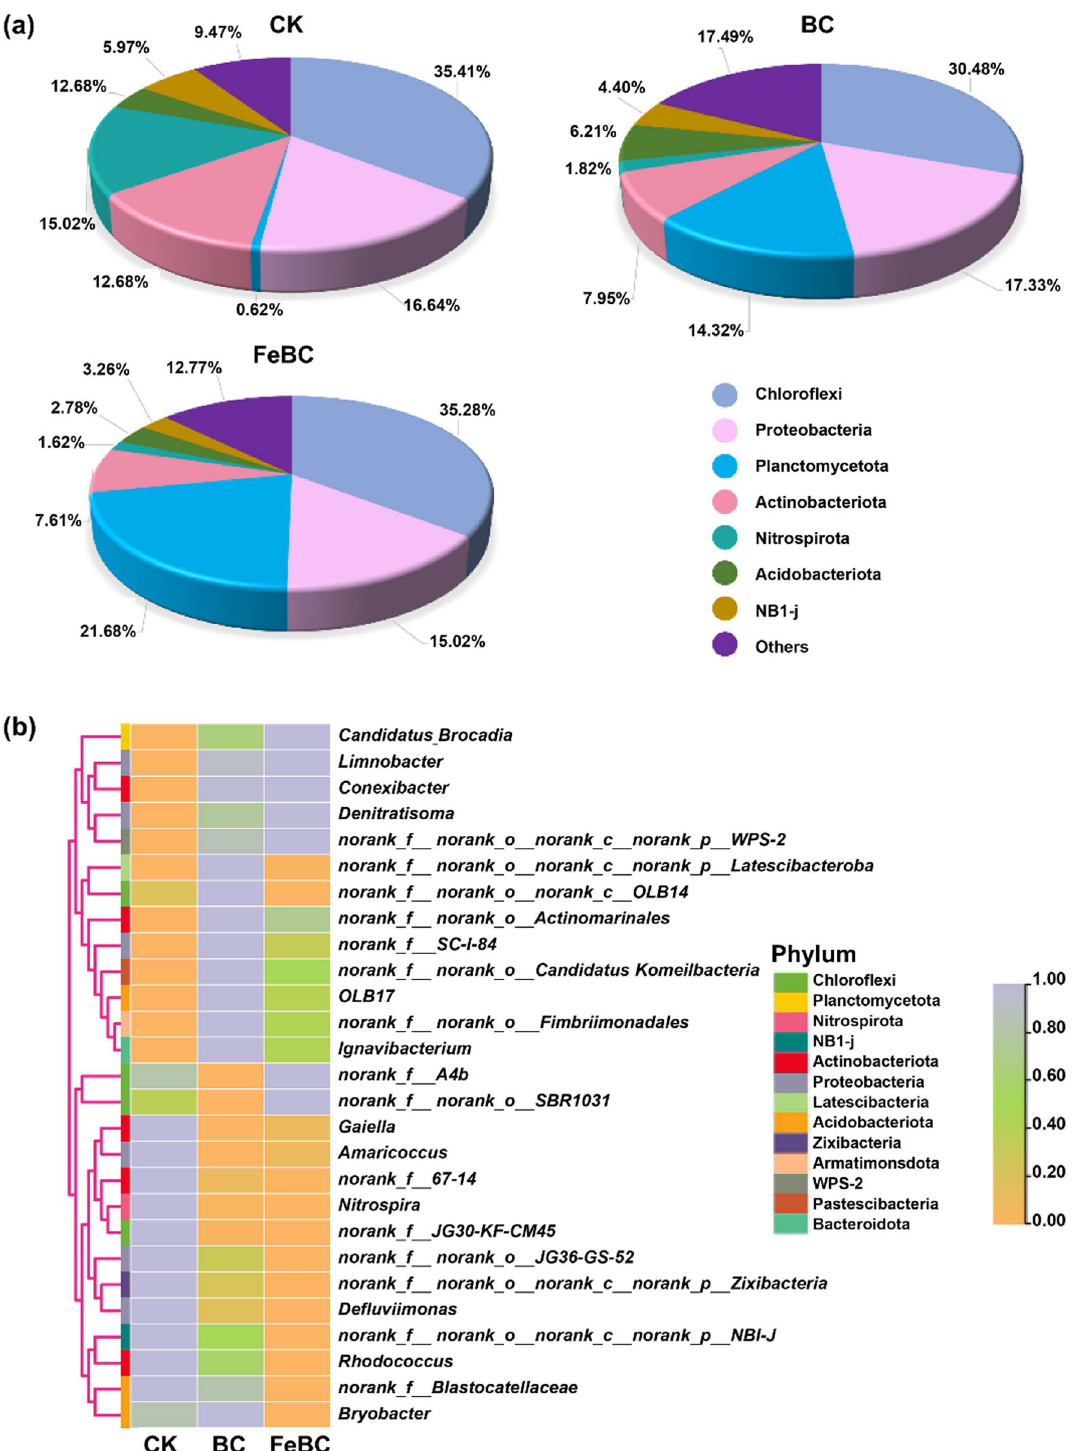
Fig. 6 Microbial community composition in the different anammox systems. a Phylum level; b heat map (row standardization) and cluster analysis at the genus